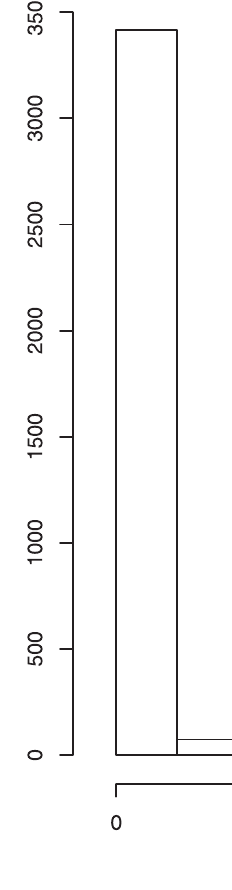
Figure 1. Histogram of log(1 + CAC).